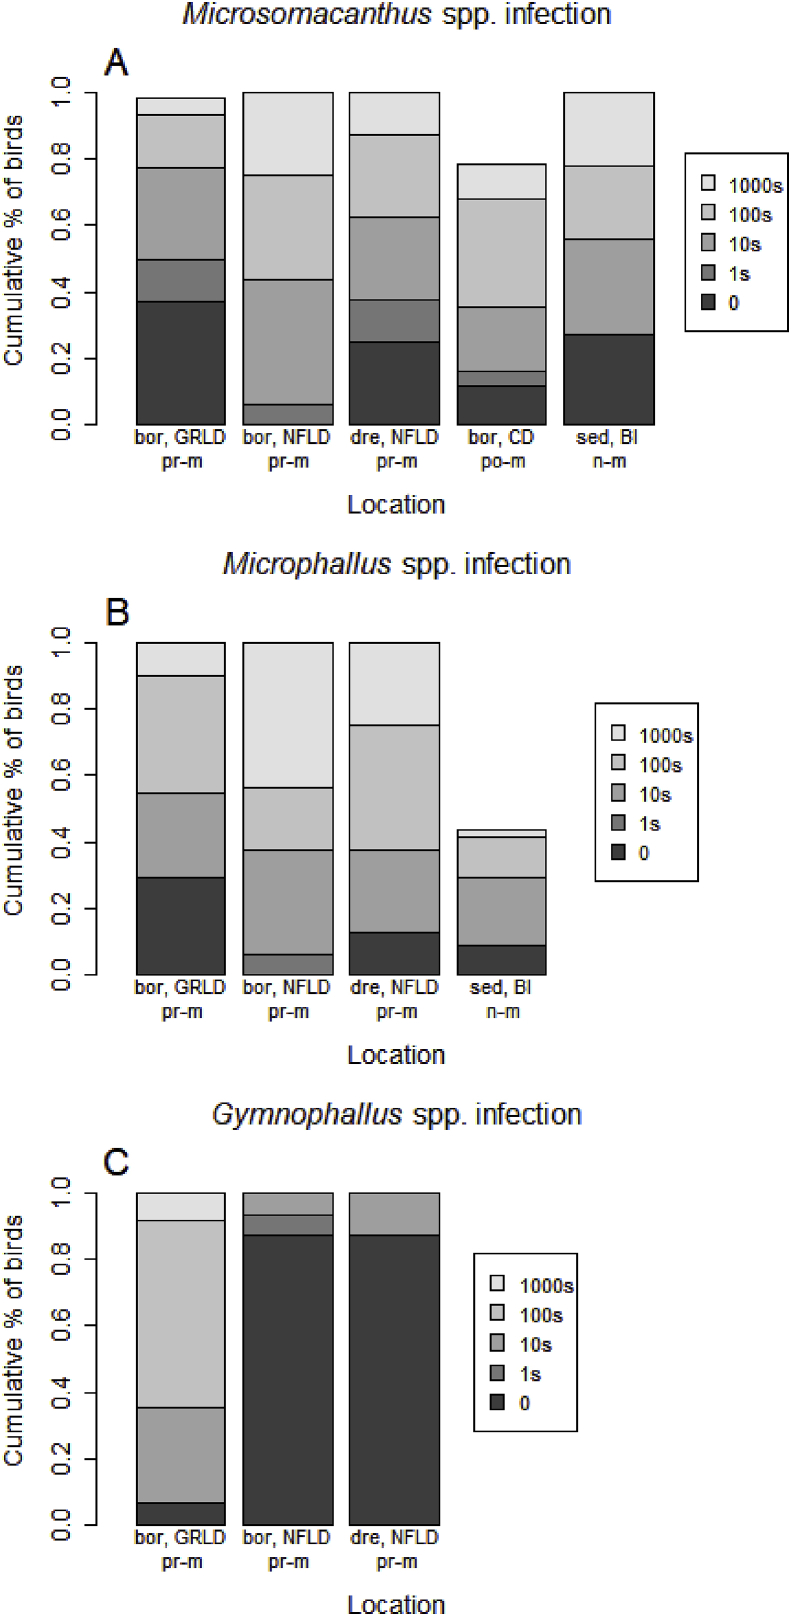
Cumulative percentages of birds infected with (A) Microsomacanthus spp., (B) Microphallus spp. and (C) Gymnophallus spp. from five different locations. Legend denotes the five infection levels: 0, 1s, 10s, 100s, and 1000s of parasite individuals within a single host. Abbreviations: bor, GRLD = S. m. borealis, Greenland; bor, NFLD = S. m. borealis, Newfoundland; dre, NFLD = S. m. dresseri, Newfoundland; bor, CD = S. m. borealis, Cape Dorset; sed, BI = S. m. sedentaria, Belcher Islands [data published in (Tourangeau et al., 2018)]. n-m = non-migratory, po-m = post-migratory, pr-m = pre-migratory.